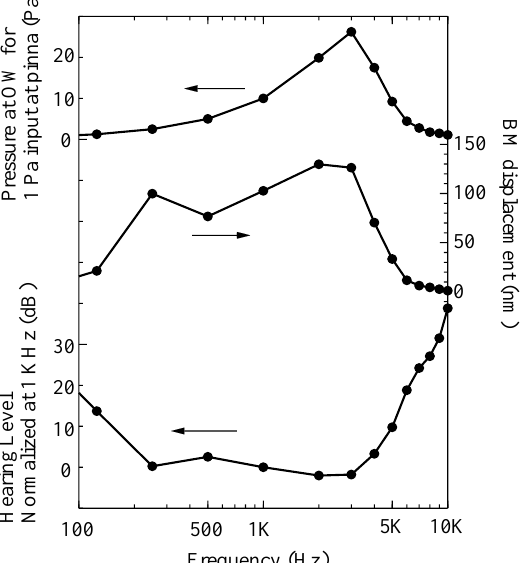
Figure 11. Looking at the sensitivity of the healthy ear, the hearing sensitivity reached the maximum around 3000 Hz and began to deteriorate above 5000 Hz.